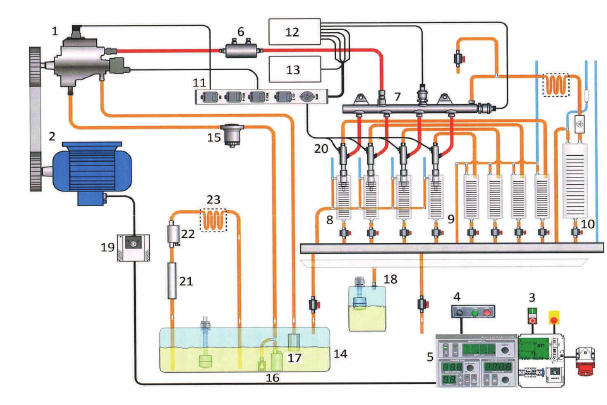
Table 2. Main property of the tested fuels Fuel property